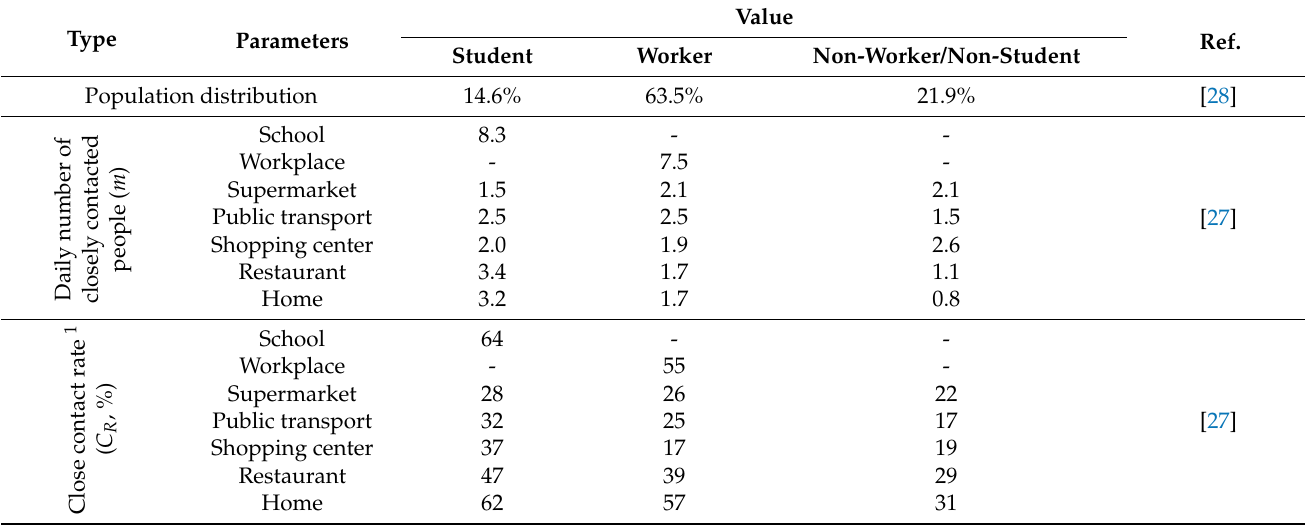
Table 1. Demographic data and close contact behavior-related parameters before the COVID-19 outbreak in Hong Kong.